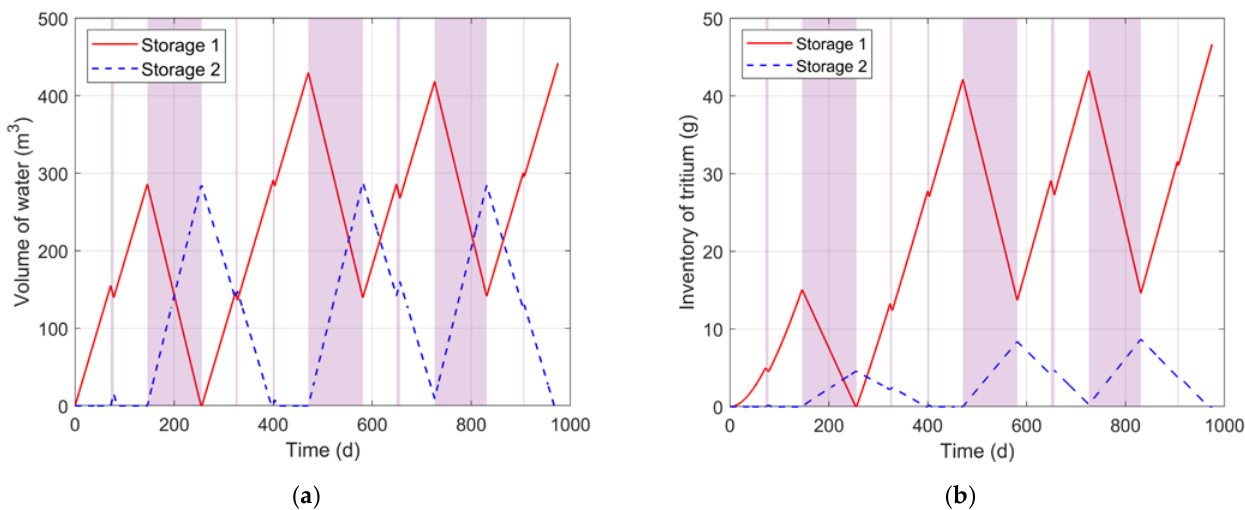
Figure 7. Operation of full hybrid water CPS under the assumed plasma operative sequence: ( a ) trend of water inventory into Storage 1 and Storage 2; ( b ) trend of tritium inventory into Storage 1 and Storage 2.